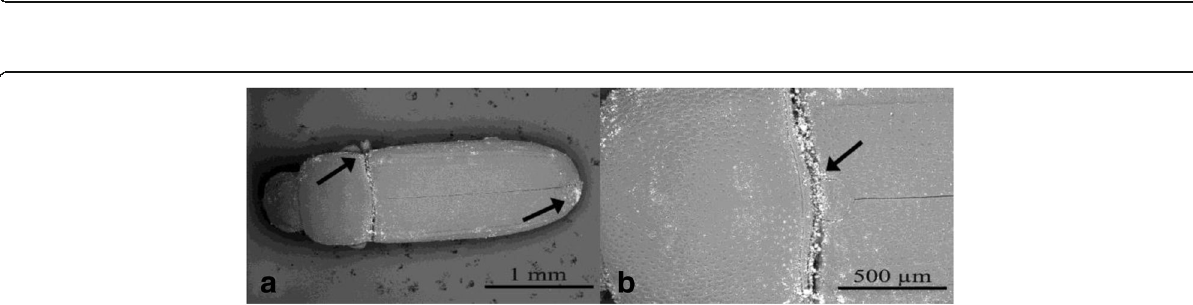
Fig. 2 Scanning electron microscope images of Tribolium confusum adults exposed to untreated wheat. a Dorsal view. b Section of dorsal